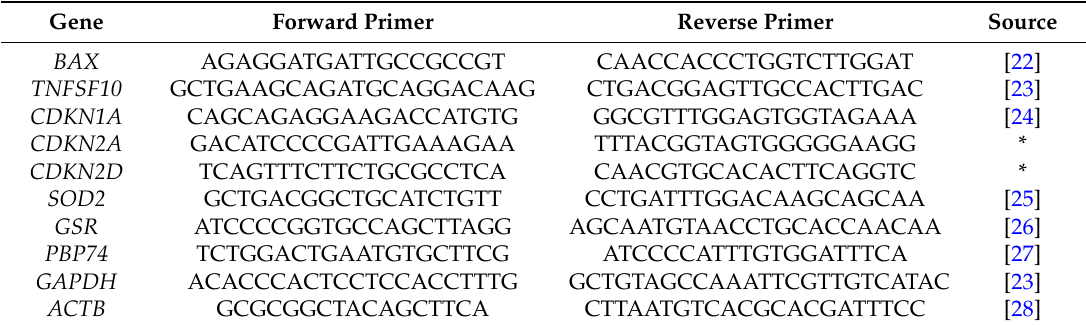
Table 4. Primer sequences for gene expression